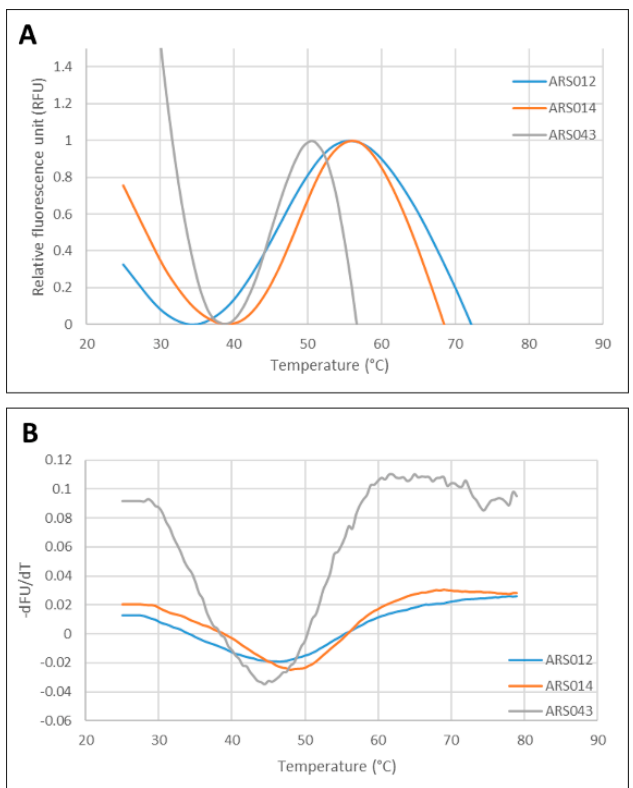
Figure 7. Analysis of thermal stability of the selected ARS binders. ( A ) Normalized thermal melting fluorescence curves of the His 6 -ARS-TolA-AVI binders. ( B ) First derivative of fluorescence versus temperature of curves shown in the panel A . The melting point is given as the lowest point of the curve. All measurements were done in duplicate and averaged. Identified temperature melting ( T m) points are as follows: ARS012 T m 45.5 °C; ARS014 T m 48 °C; ARS043 T m 44.5 °C.